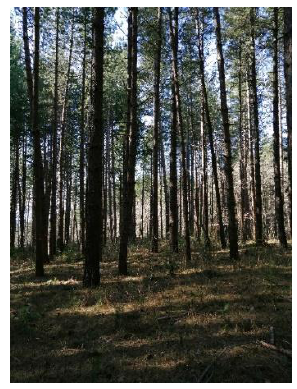
Figure 1.b Black Pine forest, plot 3